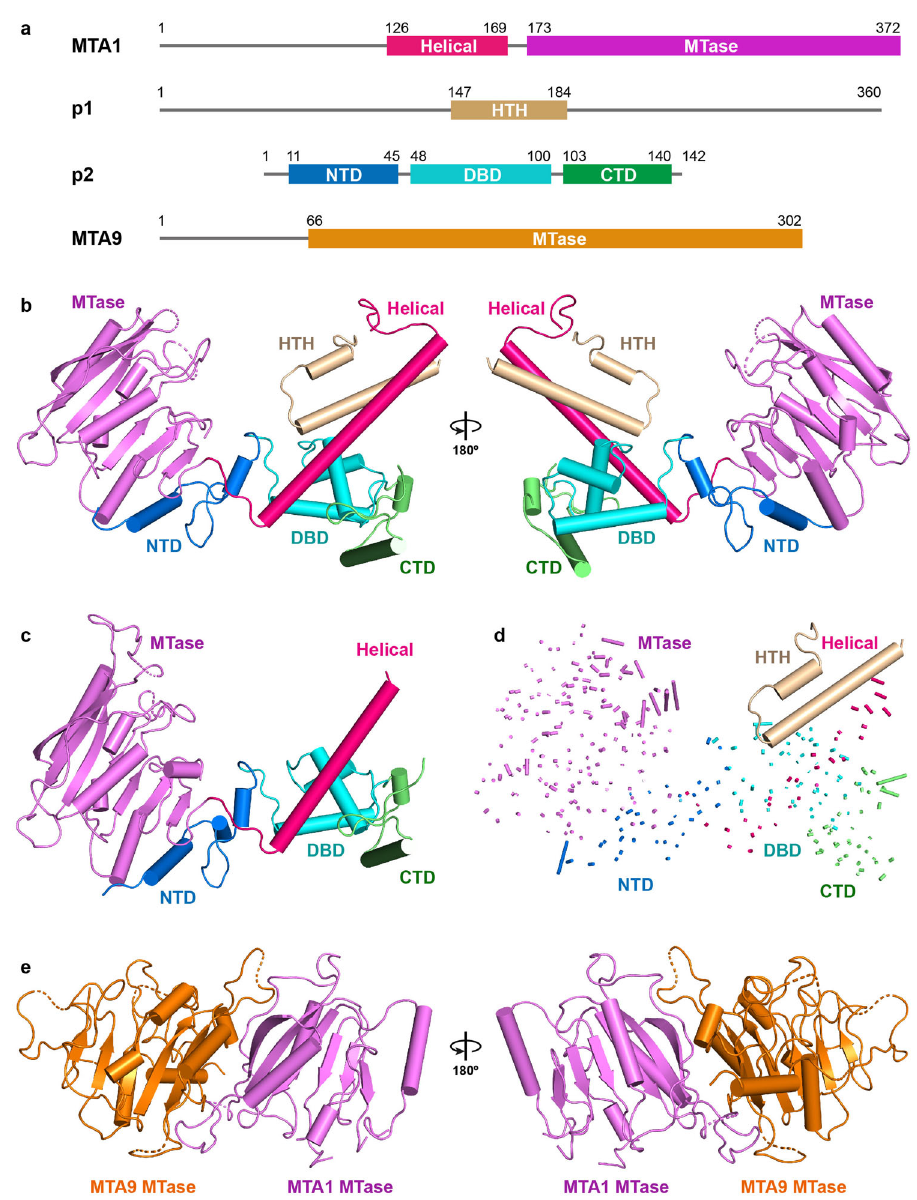
Fig. 2 Structural overview of TthMTA1-Tthp1-Tthp2, TthMTA1-Tthp2 and TthMTA1-PteMTA9 complexes. a Color-coded domain architecture of MTA1, p1, p2 and MTA9. b Front and rear views of the overall structure of the MTA1-p1-p2 ternary complex in ribbon representation. Domains of MTA1, p1 and p2 are colored according to the scheme used in ( a ). c Overall structure of the MTA1-p2 binary complex in ribbon representation. d Structural comparison of domain movement on proceeding from the MTA1-p2 binary complex to the MTA1-p1-p2 ternary complex. The C α -C α vector map is shown as lines. The vector lengths proportionally represent the domain movement between the two complexes being compared. e Front and rear views of the overall structure of the TthMTA1-PteMTA9 binary complex in ribbon